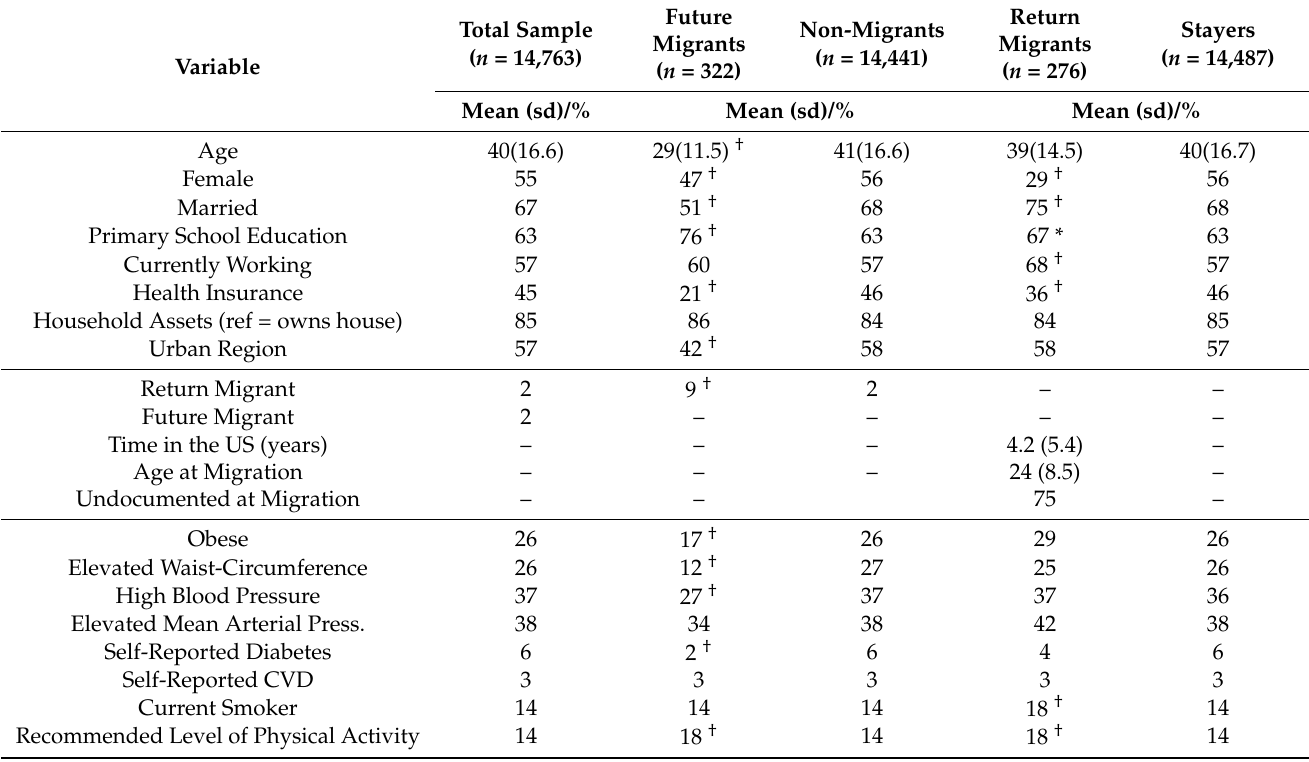
Table 1. Descriptive Statistics and Bivariate Analysis of Future Migrants vs. Non-migrants and Return Migrants vs. Stayers, MxFLS, Wave 1, n =